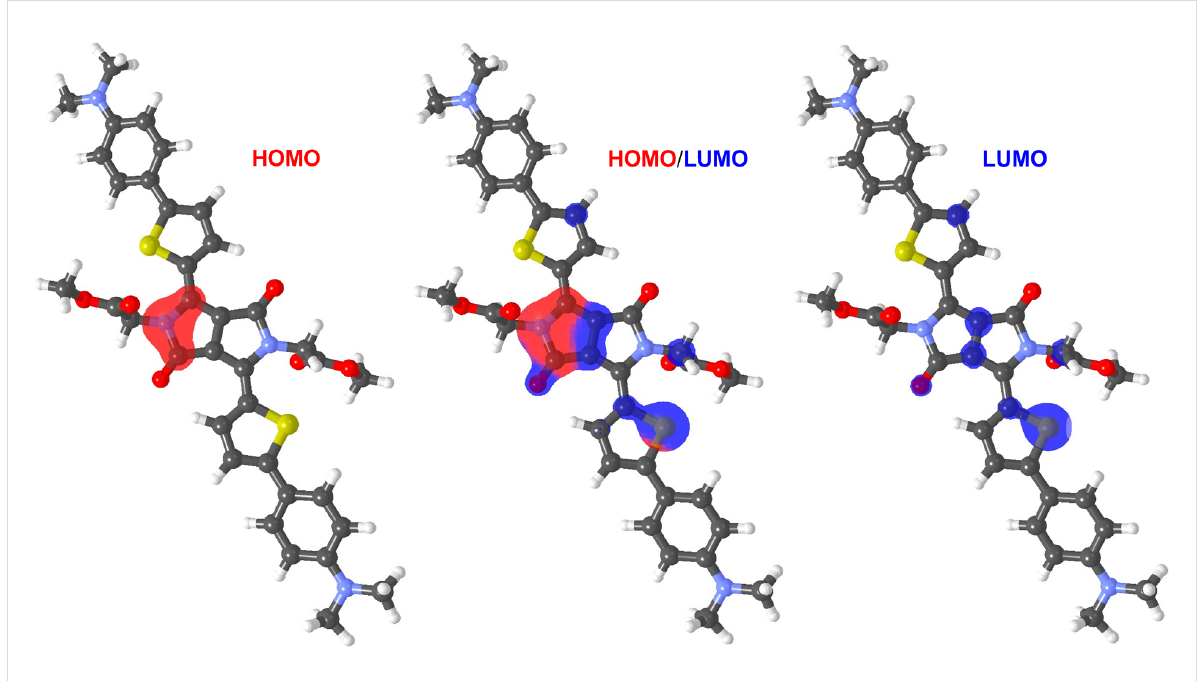
Figure 7: HOMO (red) and LUMO (blue) localizations in 1a (ethylhexyl chains